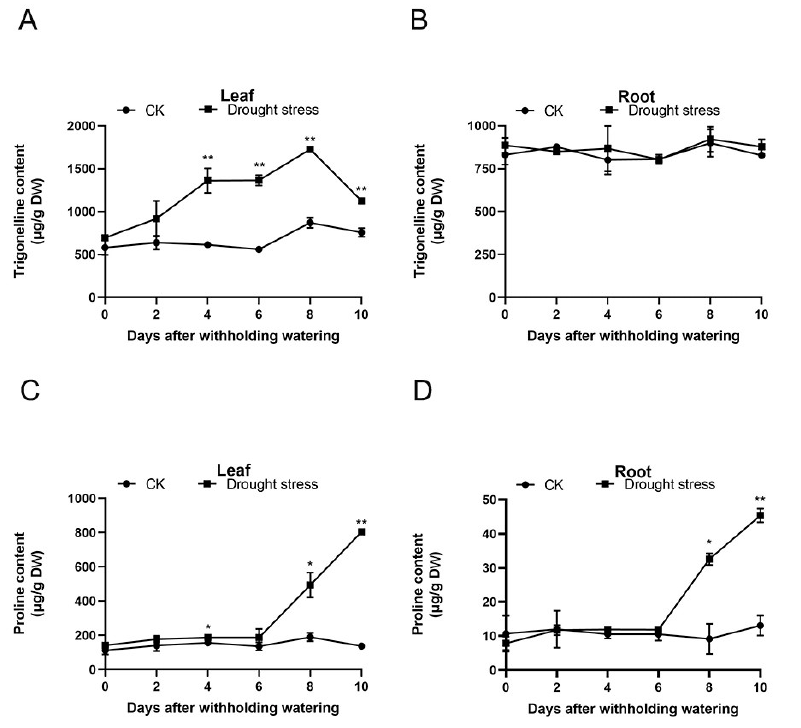
Figure 2. The content of trigonelline and proline in the areca leaves and roots ( n = 3). ( A ) The content of trigonelline in the areca leaves. ( B ) The content of trigonelline in the areca roots. ( C ) The content of proline in the areca leaves. ( D ) The content of proline in the areca roots. DW: dry weight. Data